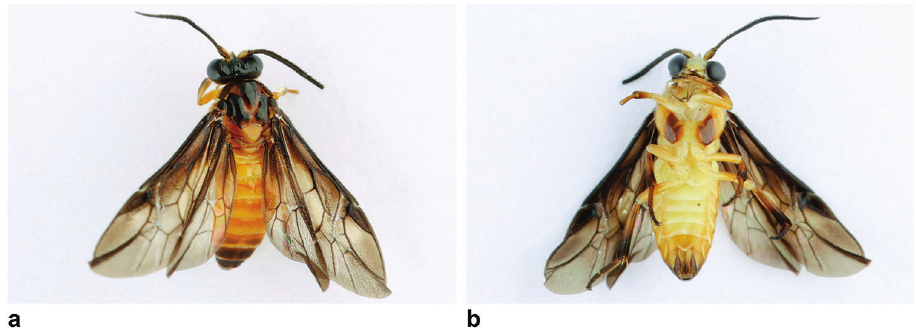
Figure 2. Manaos mammeatus , female (P4223.D), body length 6.5 mm. a Dorsal view b ventral view.